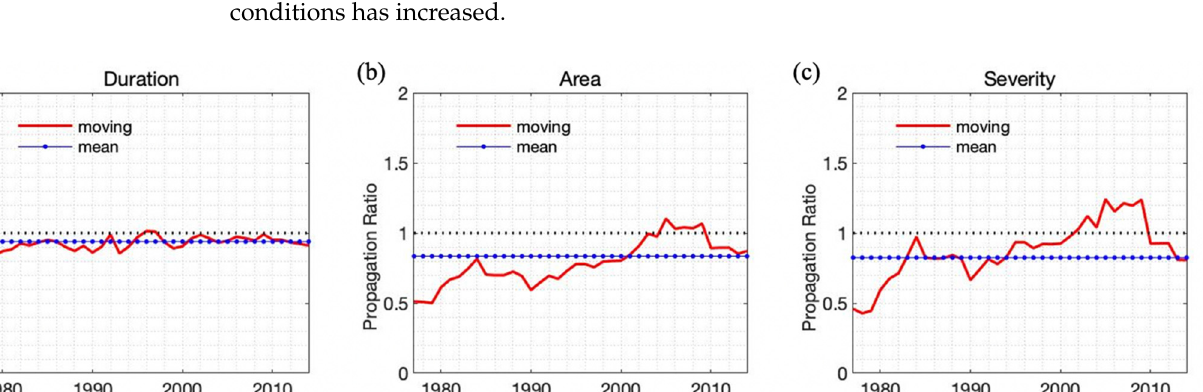
Figure 8. The change in the drought severity distribution.